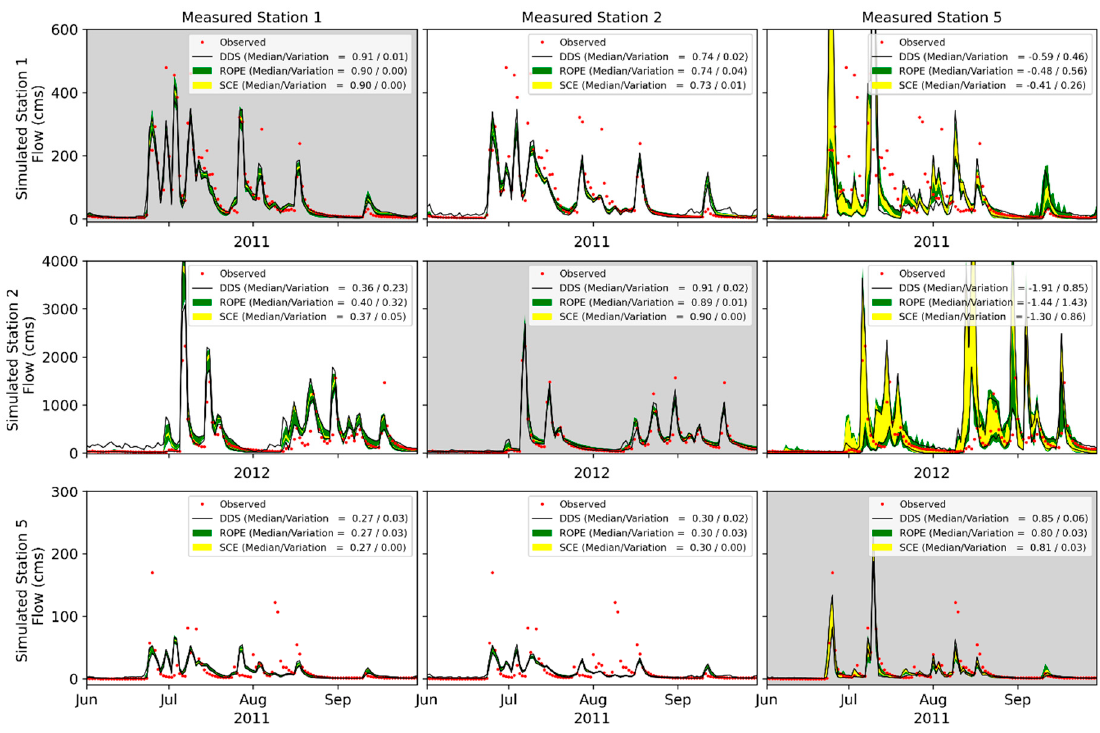
Figure 14. Cross-validation of three sites (Station 1: 1002640, Station 2: 1003630 and Station 5: 3009650) where calibrated parameters at one site are applied to the other sites. It is indicated by the shaded background when the calibrated parameters are reapplied to the same site. Model performance is reporting by the median and variation of NSE values from 100 simulations.